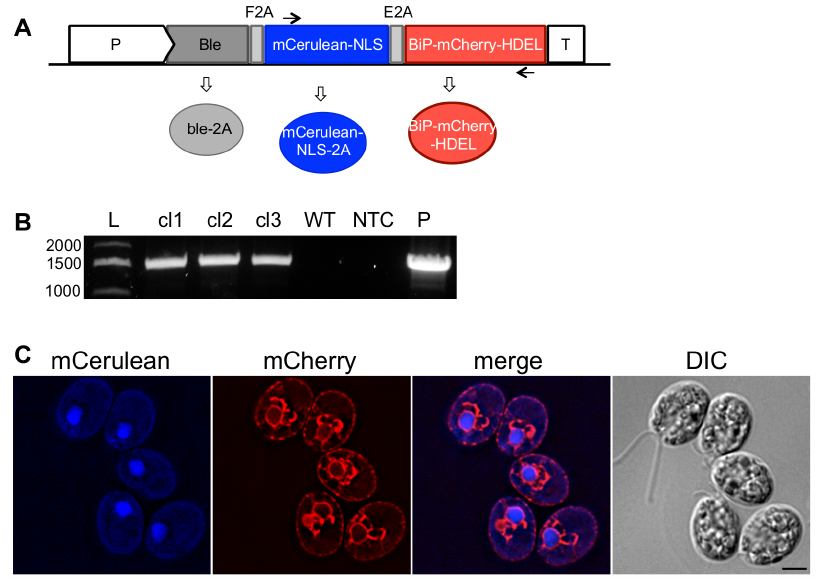
Figure 2. Gene stacking using a multi-cistronic transformation vector. A. A schematic representation of the Chlamydomonas multi-cistronic expression vector. The expression of the cassette is under the control of the hsp70/rbcs2 promoter (P). Ble confers zeocin-resistance. mCerulean is targeted to the nucleus with the SV40-NLS. mCherry is targeted to the ER using the BiP ER-TS and the HDEL retention sequence. Two 2A self-cleaving sequences are fused between the three cistrons: F2A, from FMDV1; E2A, from equine rhinitis A virus. Black arrows represent the location of the oligonucleotides used in (B). Following co-translational processing of the 2A peptides, three distinct proteins are expressed (ovals). B. PCR analysis of the multi-cistron cassette genome integration. Transformants were screened by PCR to identify individual clones that correctly integrated the multi- cistronic transformation vector, using the oligonucleotides indicated by the arrows in (A). Three independent clones (cl) are shown. L, ladder; WT, wildtype cc1690; NTC, no template control; P, plasmid. C. Live cell fluorescence microscopy of a clone expressing the multi-cistronic vector. mCerulean-NLS (blue) localizes to the nucleus while BiP-mCherry-HDEL (red) is targeted to the ER. Scale bar, 5 m m.